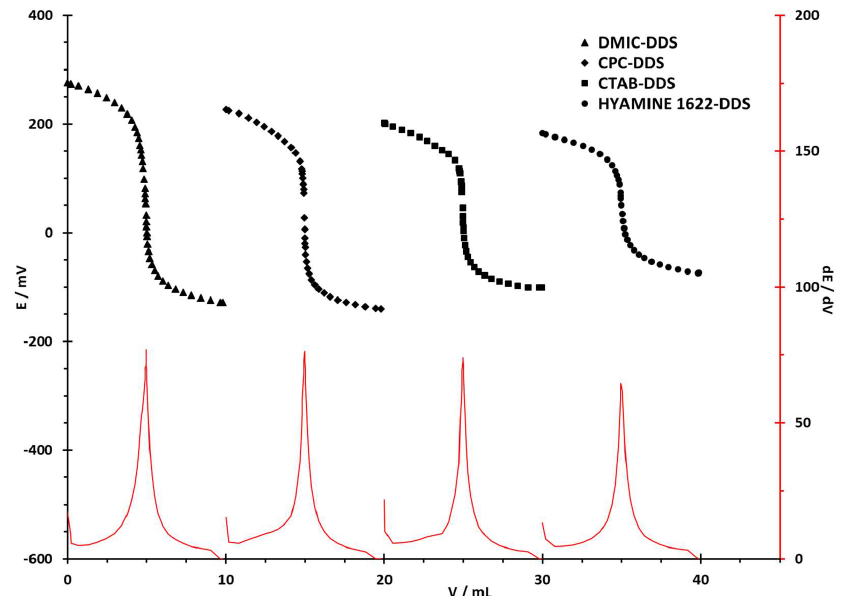
Figure 3. Potentiometric titration curves for 20 µ mol of cationic surfactant with DDS (4 × 10 − 3 M). First derivatives are presented in full as the red lines below the titration curves, with corresponding values on the secondary y-axis.